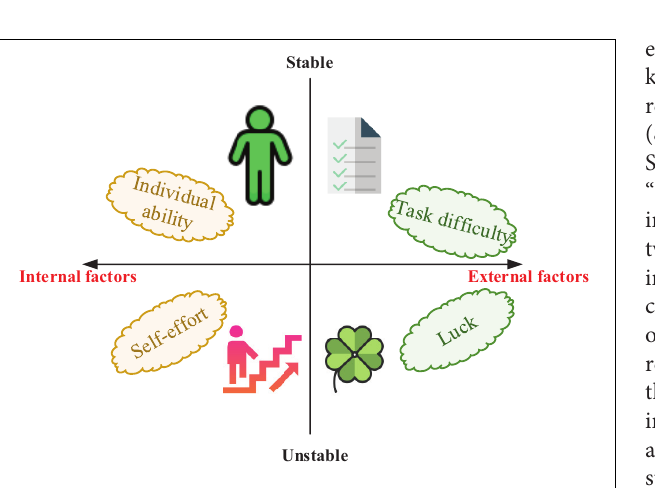
FIGURE 4 | Factors of learning obstacles of students based on attribution